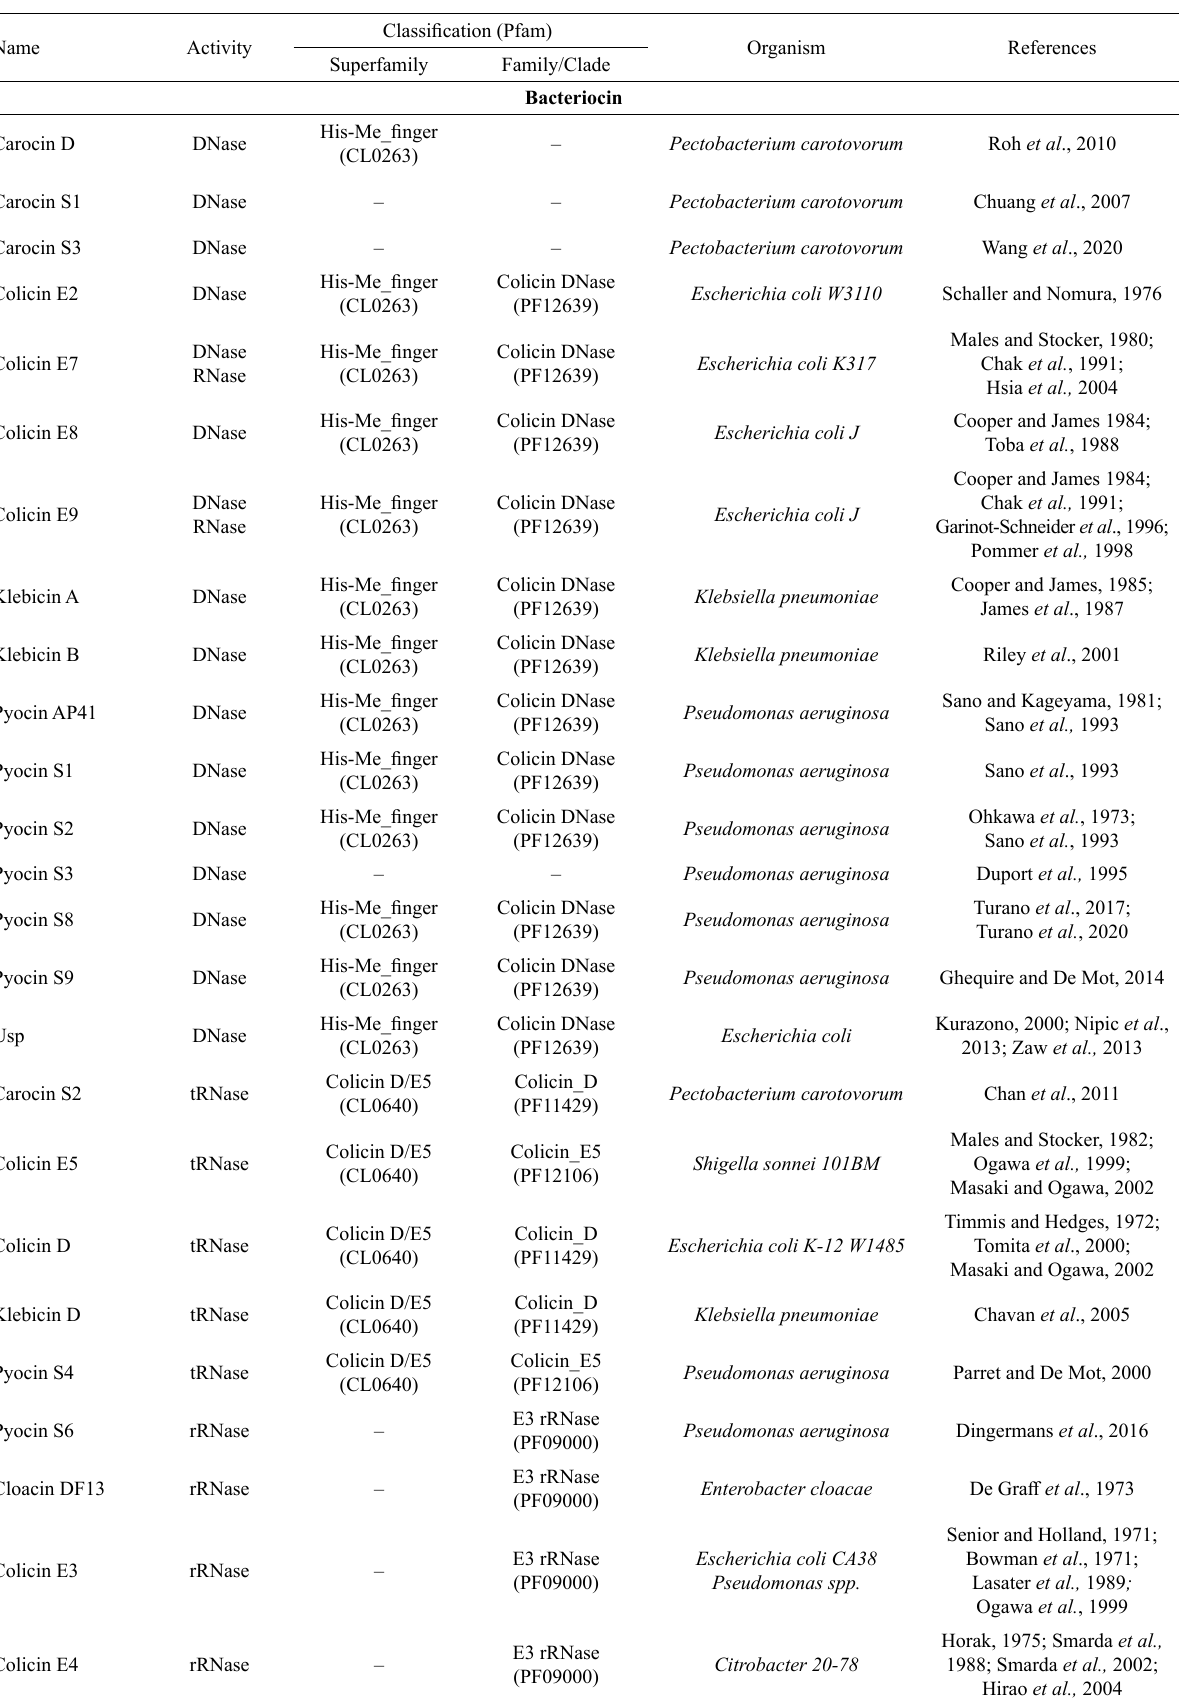
Table 1 – Antibacterial molecules that target nucleic